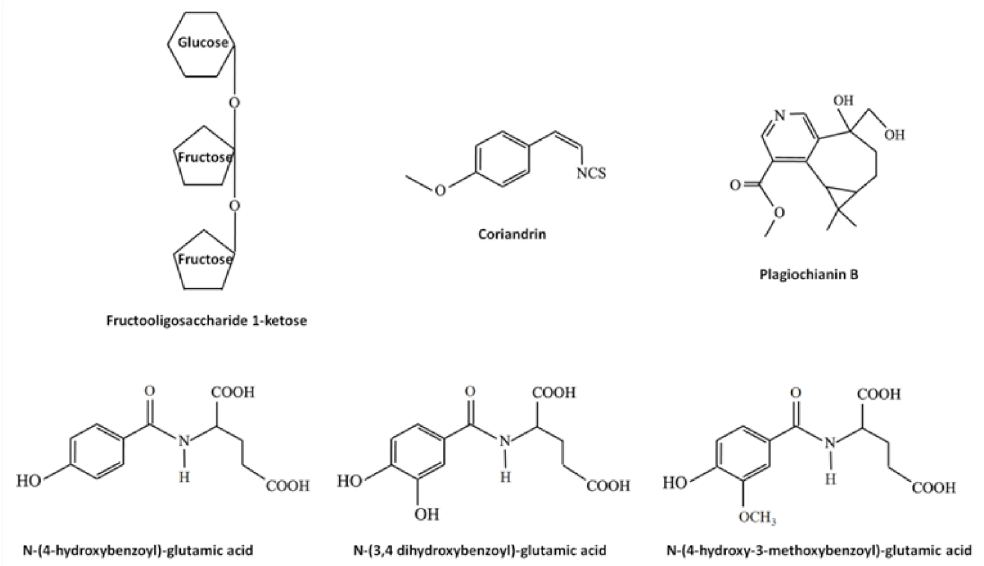
Figure 4. Some example of other molecules produced in bryophytes and three having antifungal effects, such as the N -(4- hydroxybenzoyl)-glutamic acid, N -(3,4 dihydroxybenzoyl)-glutamic acid and N -(4-hydroxy-3-methoxy-benzoyl)-glutamic